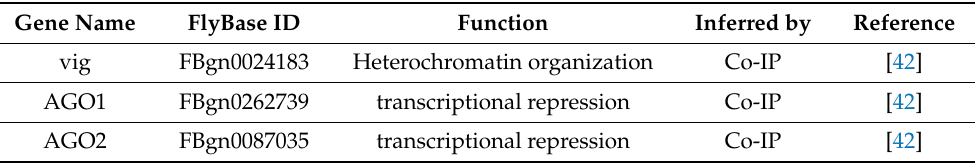
Table 3. Rpl22 interacting proteins involved in heterochromatin functions. Information retrieved from Flybase (last accessed August